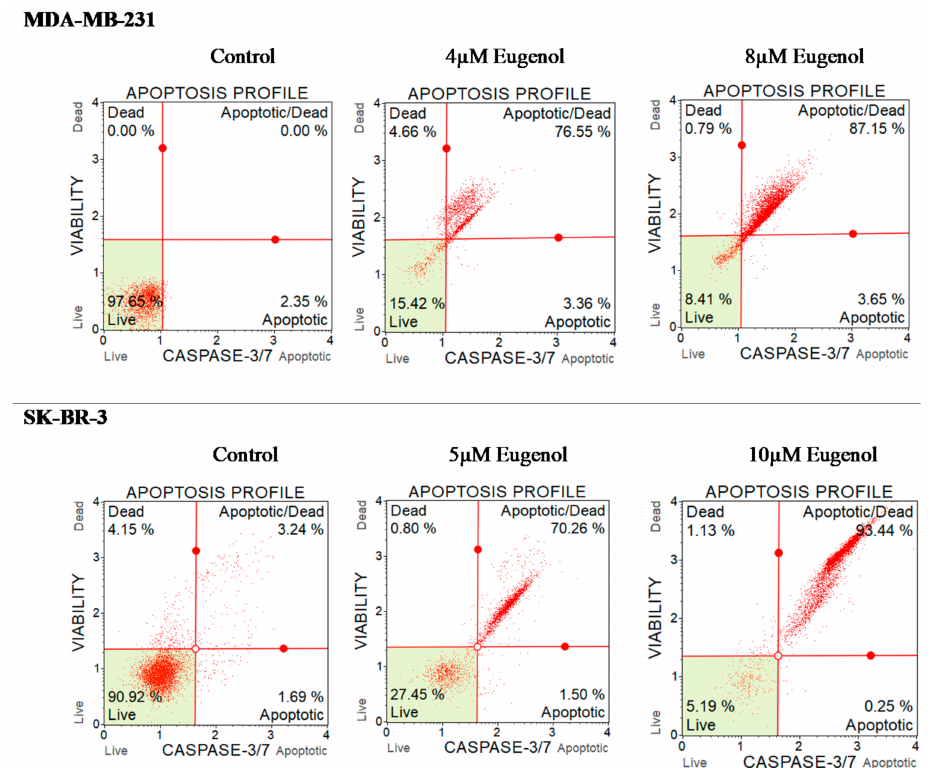
Figure 8. Effect of eugenol treatment on the percentage of apoptosis and caspase-3/7 in MDA-MB-231 and SK-BR-3 cells. Cells were treated for 24 h with eugenol (4 and 8 µ M and 5 and 10 µ M, respectively). The percentage of cells undergoing apoptosis was determined using a caspase-3/7 assay. Cells were immediately analyzed on the Muse™ Cell Analyzer (Merck KGaA Co., Darmstadt,